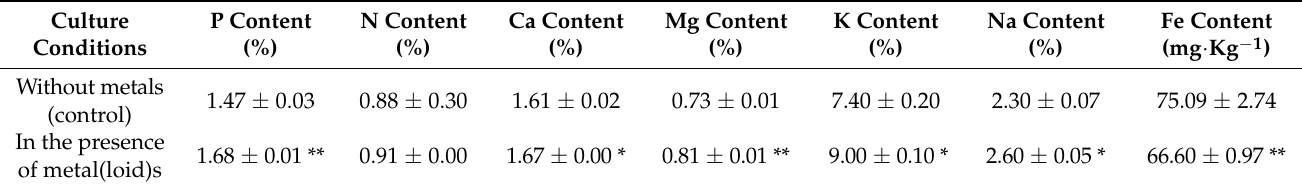
Figure 1. Dry biomass of shoots ( A ) and roots ( B ) of Mesembryanthemum crystallinum plants grown in the absence (grey bars) and presence (black bars) of a mixture of metals and metalloids (10 µM As + 1 µM Cd + 20 µM Cu + 50 µM Zn), non-inoculated (NI) or inoculated with TSA or MA SynComs. Data are means of 10 independent determinations ± standard deviations. Statistically significant differences with respect to the non-inoculated control plants at p < 0.05 are indicated by different letters (upper case for the plants grown in the absence of metals and lower case for plants grown in the presence of a mix of metals). ( C ) Aspect of inoculated vs. non-inoculated plants grown in the presence of metals. Table 3. Content of macro- and micronutrients in plants of Mesembryanthemum crystallinum in the regard to control